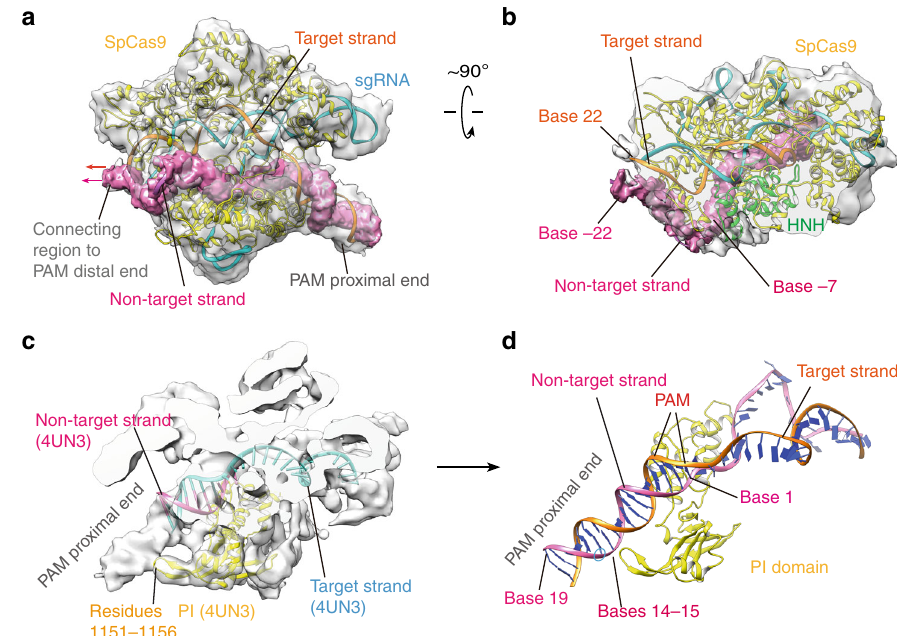
Fig. 4 The SpCas9-bound topology of the non-target DNA strand (bases − 22 to 19). a The EM density (contoured at ~1.0 σ ) corresponds to the non-target strand from the base-paired PAM proximal end to the connecting region of the PAM distal end to SpCas9 (in hot pink). The possible positions of the PAM distal end are indicated by arrows. For clarity, the HNH domain is not presented in the atomic model (in cartoon). b Top view of the density and possible connecting bases of the PAM distal end to SpCas9. c The EM map (contoured at ~4.0 σ ) reveals a binding interaction of the PAM proximal end with SpCas9 segment 1151 – 1156. The fi tted atomic model is the crystal structure 4UN3 (Fig. 1c, d). d The bases of the non-target strand that interact with